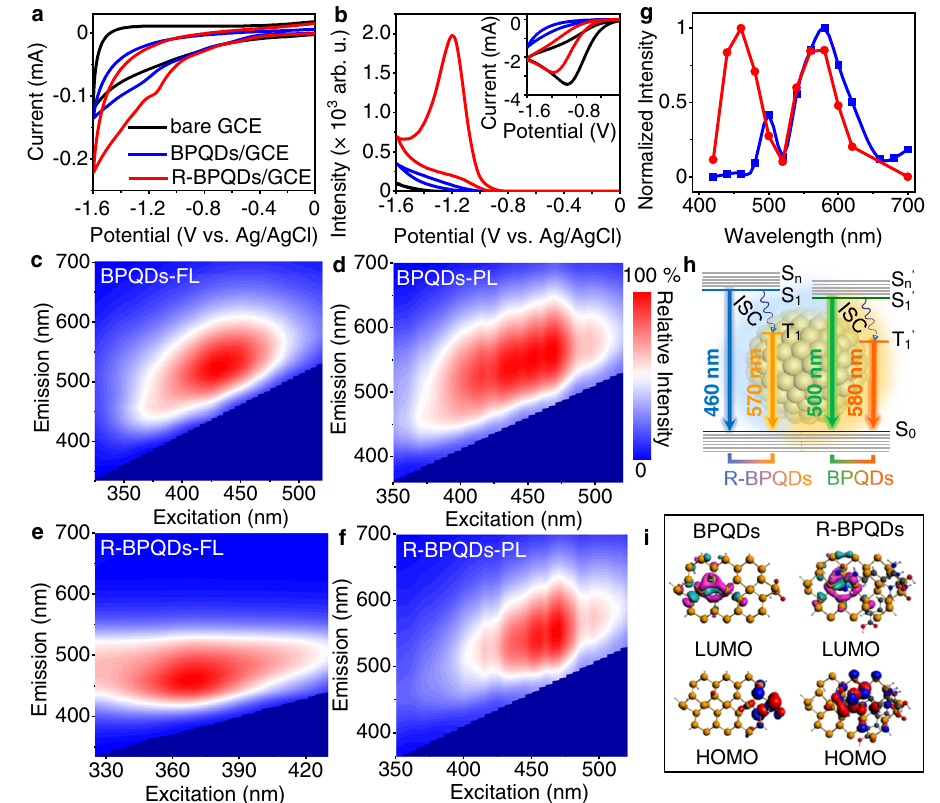
Fig. 2 | Cathodic ECL and photophysical properties before (BPQDs/GCE, blue) and after Arg modi fi cation (R-BPQDs/GCE, red). a CVs of glassy carbon elec- trodes (GCEs) in 0.1M PBS. b ECL curves of GCEs in 0.1MpH 7.4 PBS containing 0.1M K 2 S 2 O 8 . PMT=600V. Inset: CVs for ( b ). c – f Excitation-emission maps